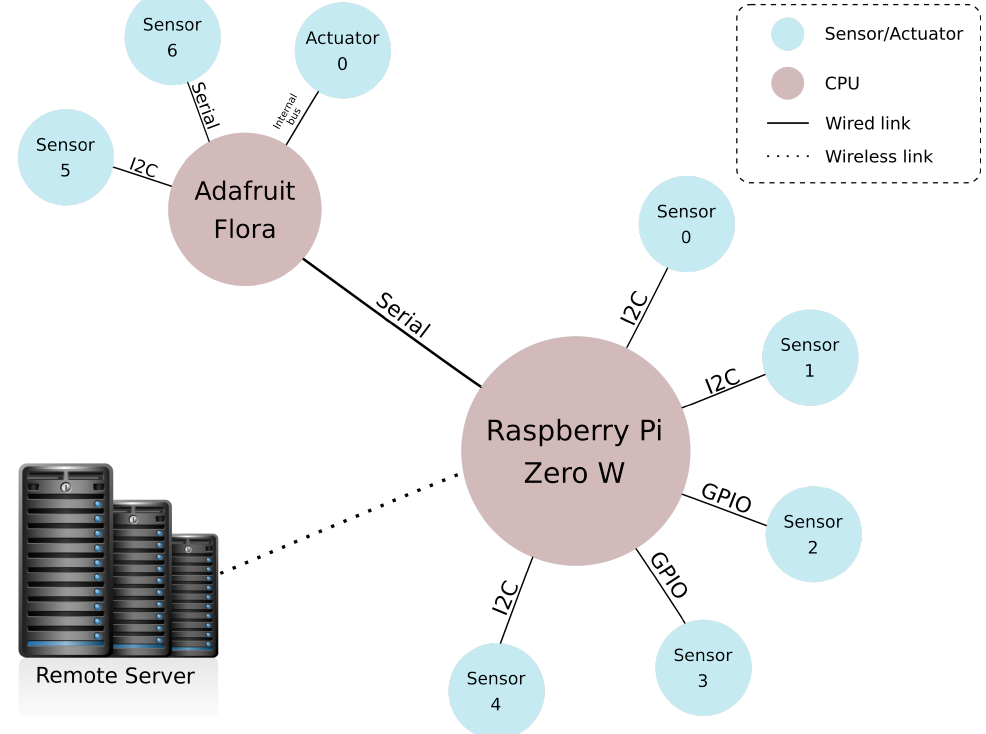
Figure 5. Wearable prototype for surface mining: CPU, sensor nodes and communication links